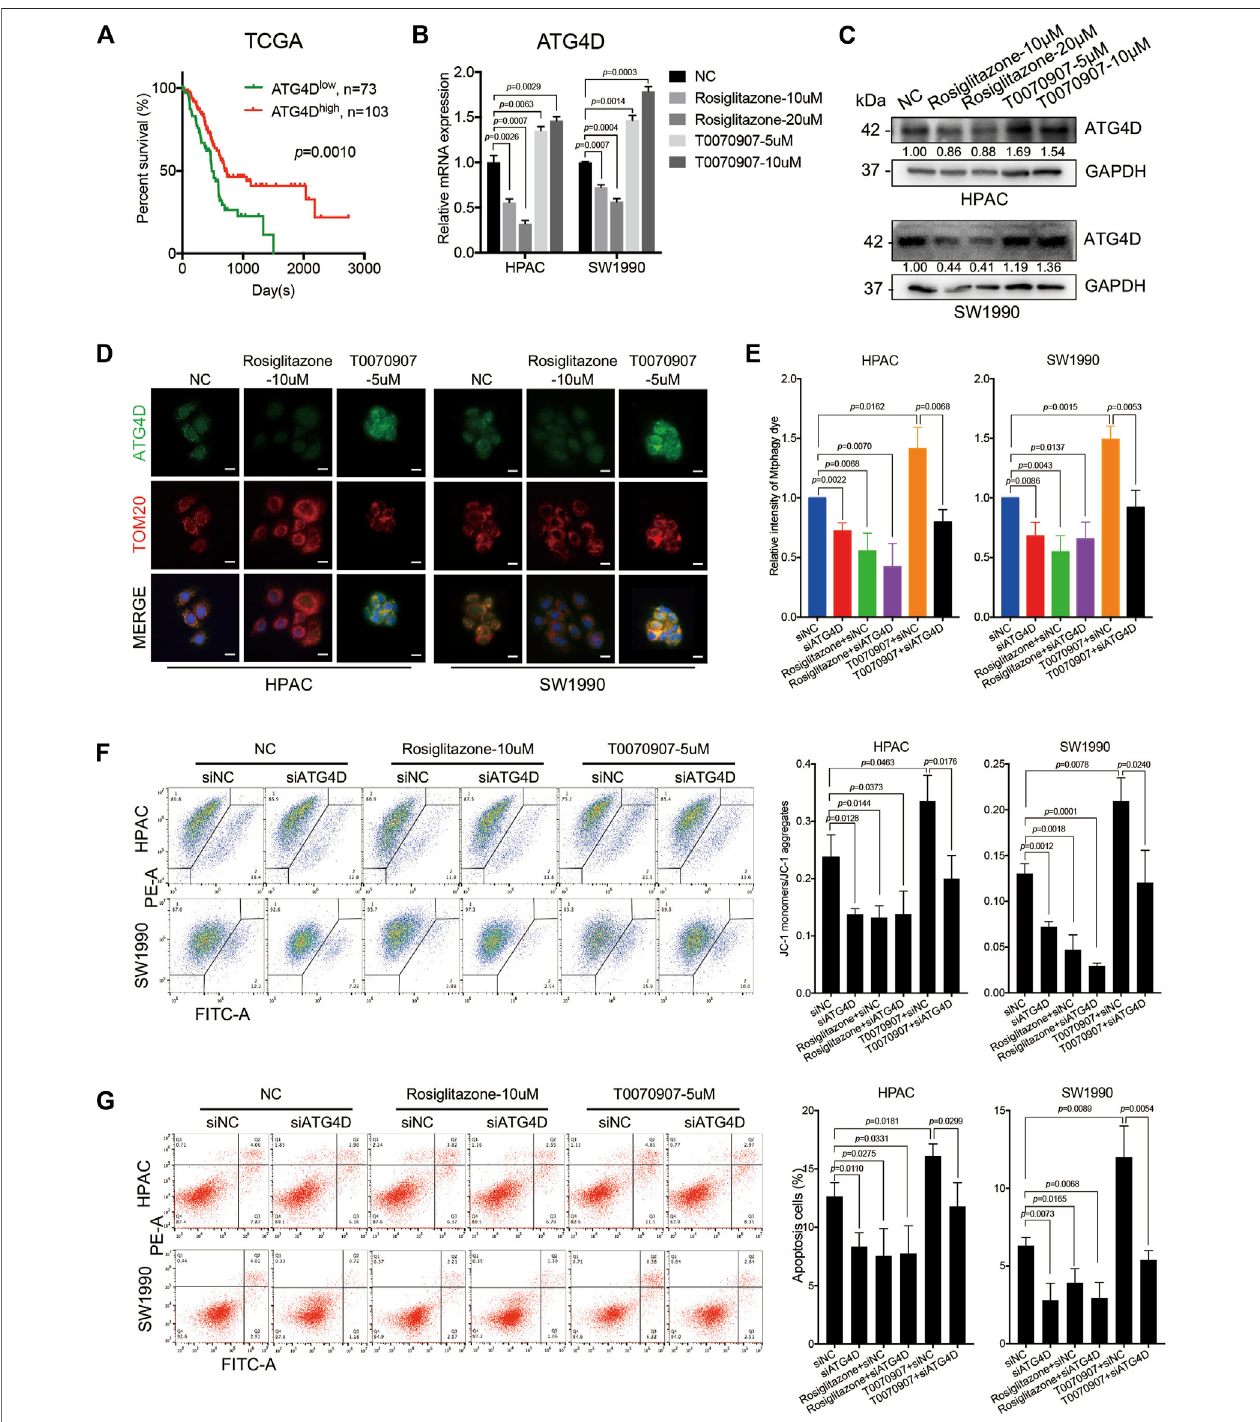
FIGURE 5 | PPAR γ downregulates ATG4D-mediated mitophagy to decrease mitochondrial ROS-dependent apoptosis. (A) In TCGA dataset, the mRNA expression level of ATG4D was negatively correlated with PDAC patients ’ overall survival time ( p = 0.0010). (B) Treating HPAC or SW1990 cells with negative control, Rosiglitazone (10, 20 μ M) or T0070907 (5, 10 μ M) for 72 h affected the mRNA expression level of ATG4D. (C) Treating HPAC or SW1990 cells with negative control, Rosiglitazone (10, 20 μ M) or T0070907 (5, 10 μ M) for 72 h affected the protein expression level of ATG4D. (D) The expression and location of ATG4D was mainly changed on mitochondria after treating HPAC or SW1990 cells with negative control, Rosiglitazone (10 μ M) or T0070907 (5 μ M) for 72 h. (E) Knockdown of ATG4D by siRNA in HPAC and SW1990 cells decreased mitophagic fl ux with or without Rosiglitazone (10 μ M) or T0070907 (5 μ M). (F) Knockdown of ATG4D by siRNA in HPAC andSW1990cellsstabilizedmitochondrialmembranepotentialwithorwithoutRosiglitazone(10 μ M)orT0070907(5 μ M). (G) KnockdownofATG4DbysiRNAinHPAC and SW1990 cells decreased cell apoptosis with or without Rosiglitazone (10 μ M) or T0070907 (5 μ M). Experiments were repeated at least three times, with statistical analyses being reported